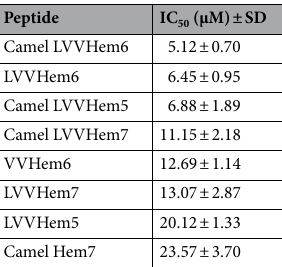
Table 3. IC 50 (mean ± SD) of the peptides tested against ACE1.